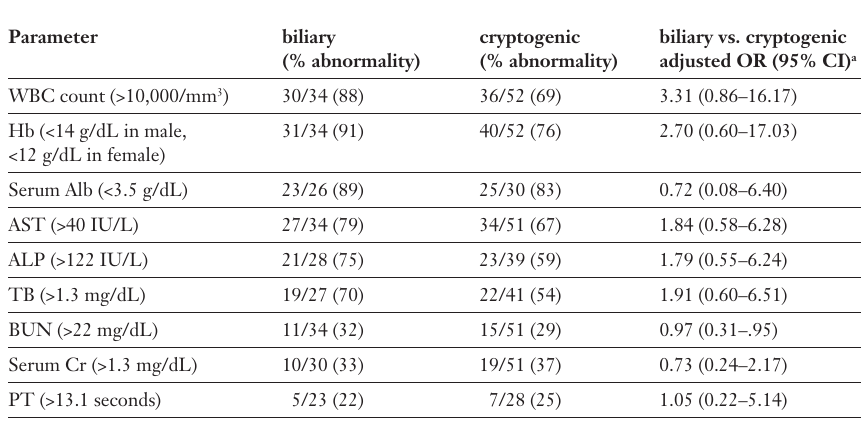
Laboratory findings in the biliary and cryptogenic